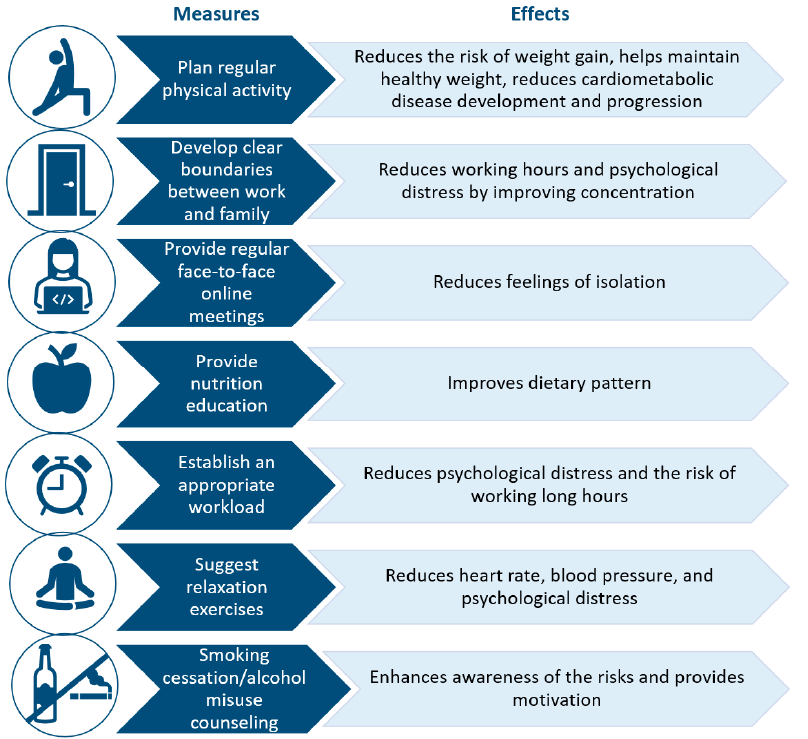
Figure 3. Measures to reduce cardiovascular disease risk while working from